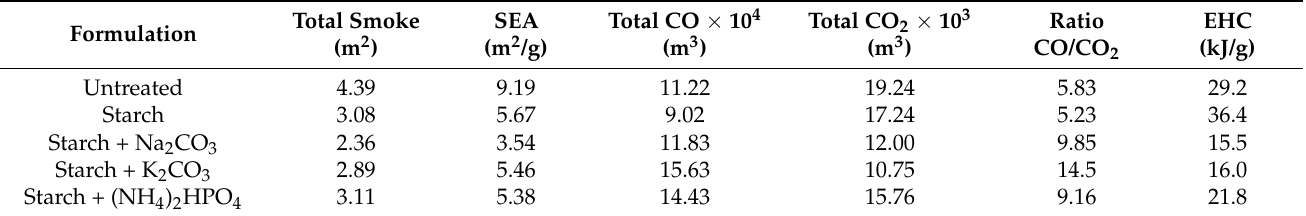
Table 2. The average values of SEA, EHC, total smoke, total CO and CO 2 , and their ratio measured in the standard cone Table 1. The averages of THR, HRR, and MLR and the corresponding peak values measured in the standard cone calo ‐ calorimeter at 35 kW/m 2 . rimeter at 35 kW/m 2 .